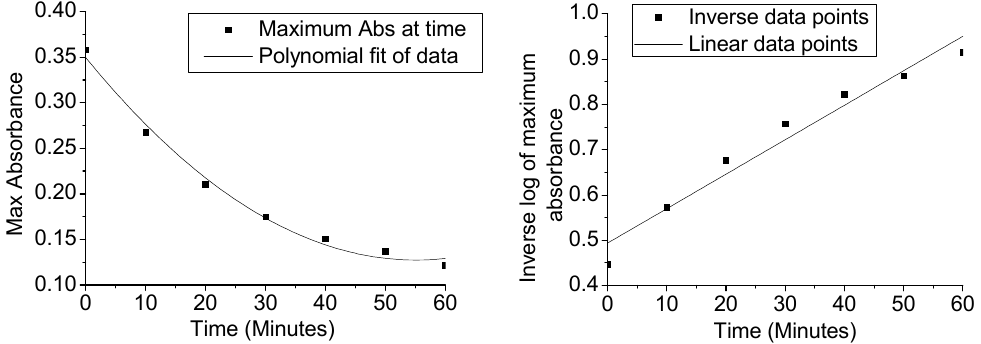
Figure 11. Graph of the changes in the maximum of dye absorbance plotted against time for catalytic CoFe 2 O 4 @SiO 2 @TiO 2 nanoparticles sintered at 600 °C ( Left ). Graph of Log (1/Max Abs) versus time for the catalytic CoFe 2 O 4 @SiO 2 @TiO 2 nanoparticles sintered at 600 °C ( Right ).